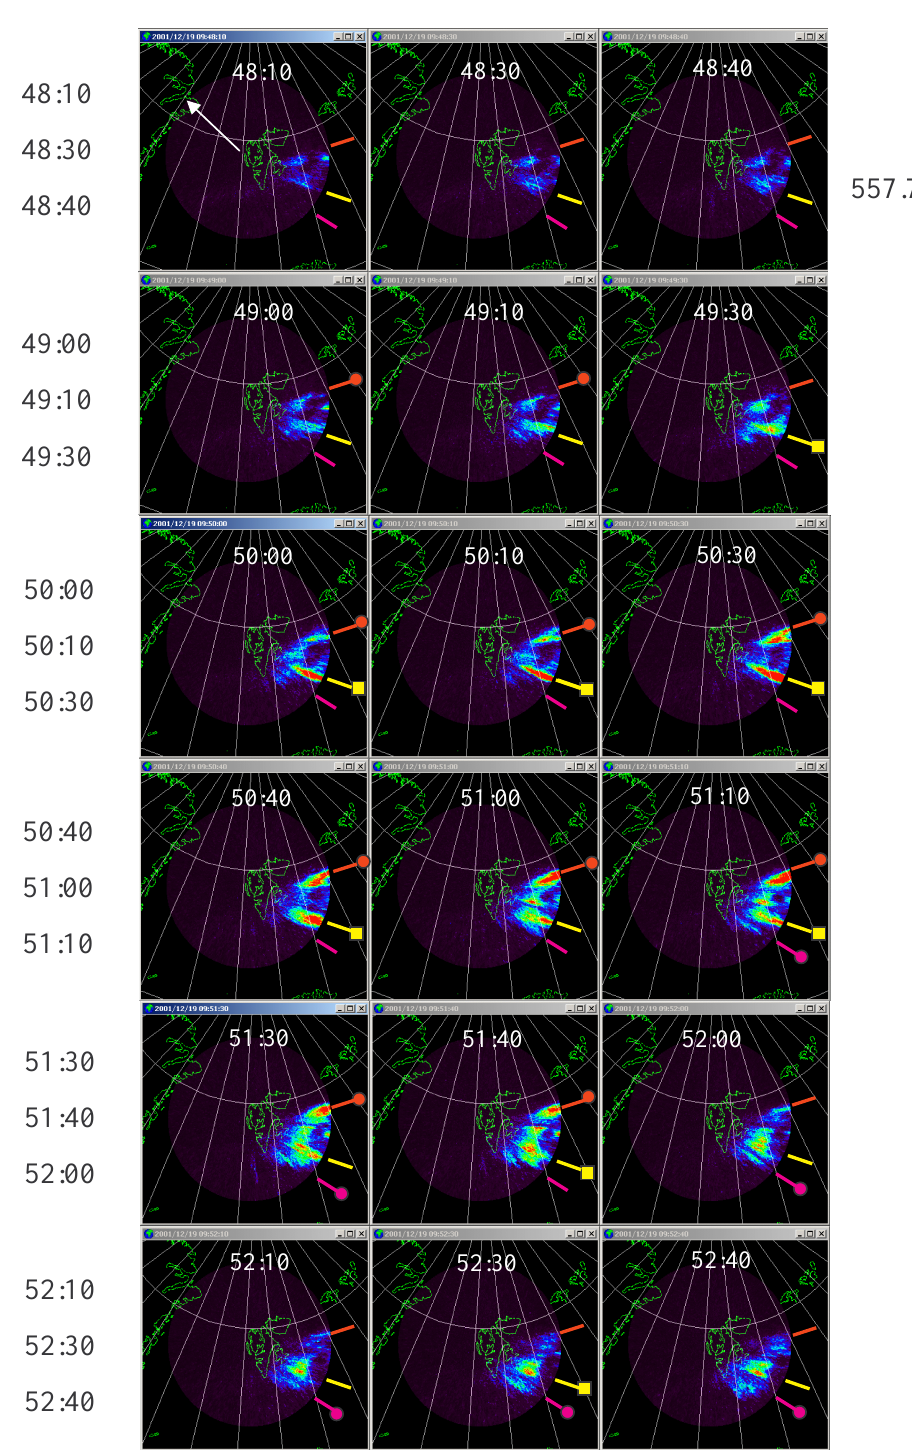
Figure 4 Fig. 4. All-sky images of 557.7-nm emissions over Ny- ˚Alesund taken at a cadence of 10s on 19 December 2001, from 09:48:10 to 09:52:40 UT. Occasionally, intervals are missing while other wavelengths were sampled. The images are mapped to 190km on a geo- graphic grid. Magnetic north is approximately in the direction of the white arrow in the upper left image. Red, yellow, and pink fiducials have been added at the same location in each image to guide the eye. Squares or circles indicate that a region is